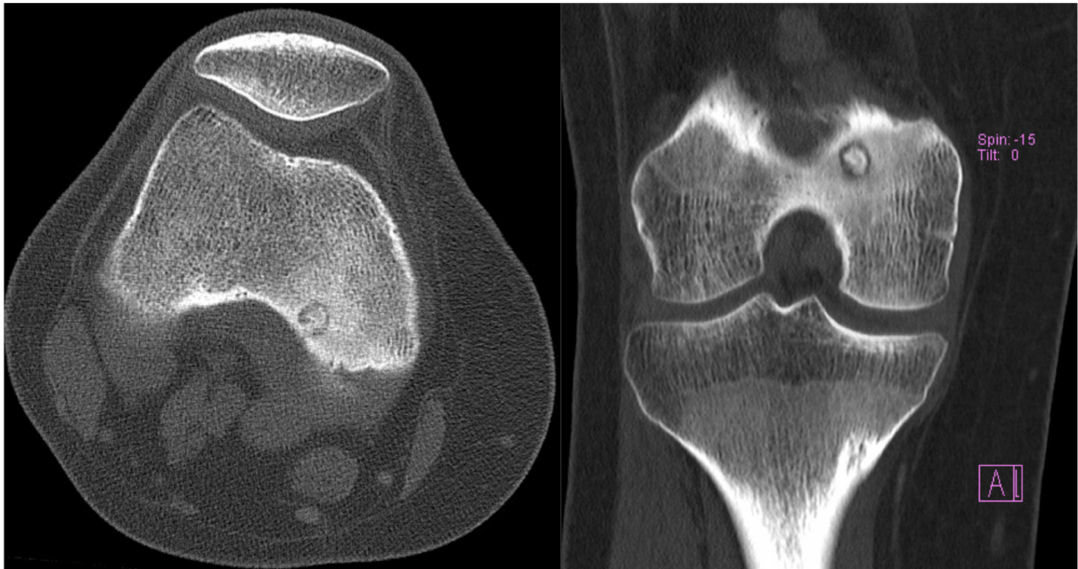
Figure 2. Pre-treatment axial and coronal CT of a knee confirming an osteoid osteoma of the posterior medial distal femur.